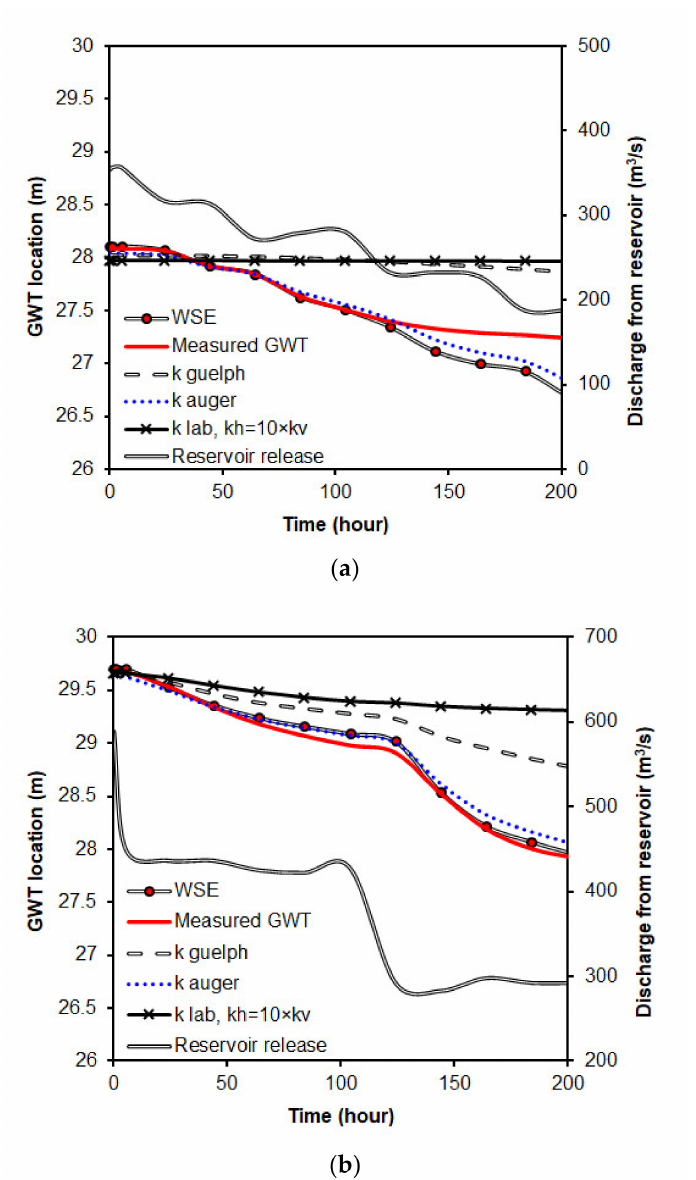
Figure 11. Changes in the GWT with hydraulic conductivity values determined from the field and laboratory tests for ( a ) 23–31 May 2008 and ( b ) 20–29 June